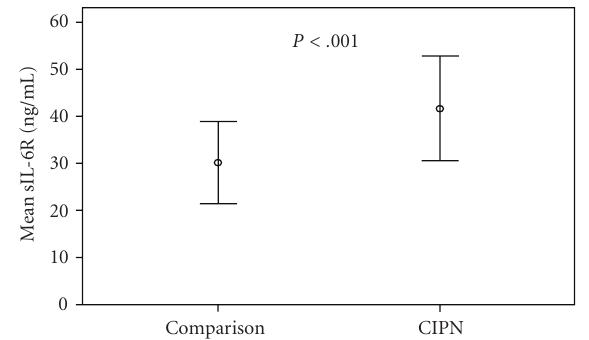
Figure 2: Mean levels of serum Soluble IL-6R in women with painful CIPN ( N = 20) and women without CIPN symptoms (Comparison Group, N = 20). Dots represent mean value of soluble IL-6R (sIL-6R) measured in serum; error bars represent 95% CI. Mean (SD), [Range] of the Painful CIPN group: 41.6 (9.7)ng/mL [31–54]; Comparison group: 30.2 (5.8)ng/mL [22–39]. Independent t -test with Bonferroni correction performed to exam- ine di ff erence between groups: ( t (38) = − 5.1, P < .